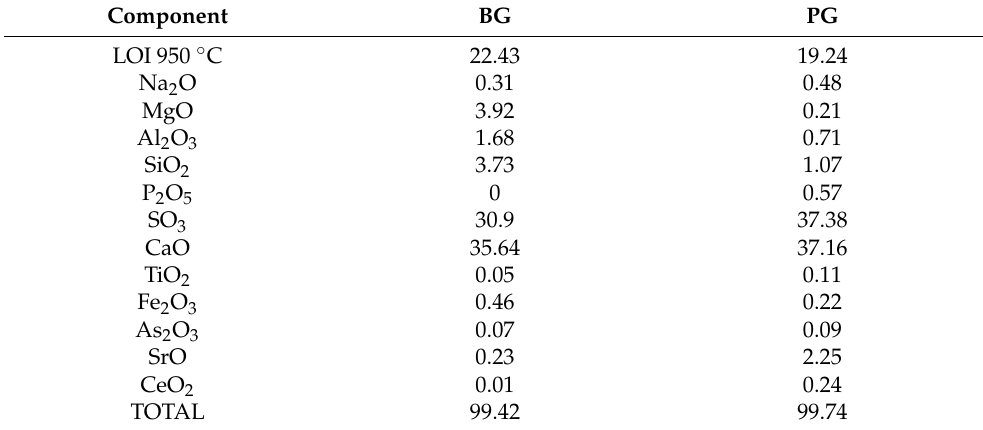
Table 1. Chemical composition of commercial gypsum BG and phosphogypsum